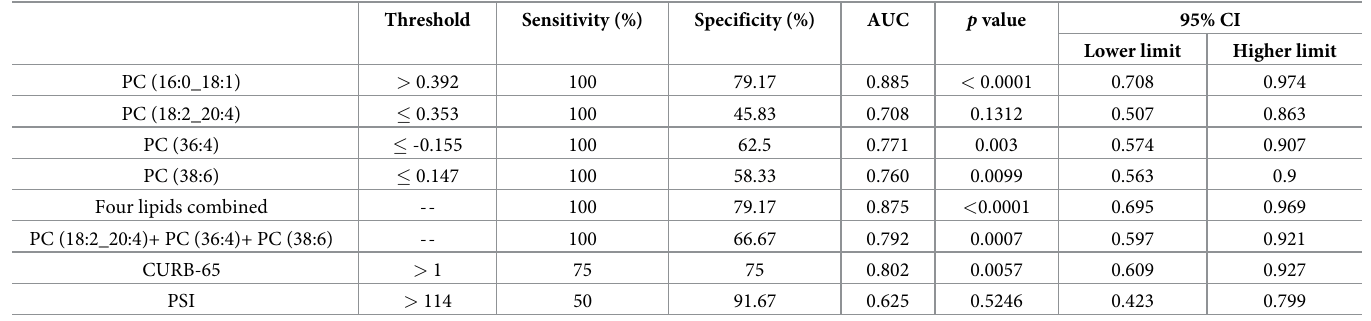
Table 4. Area under the curve (AUC) and thresholds for discriminating non-survivors from patients with